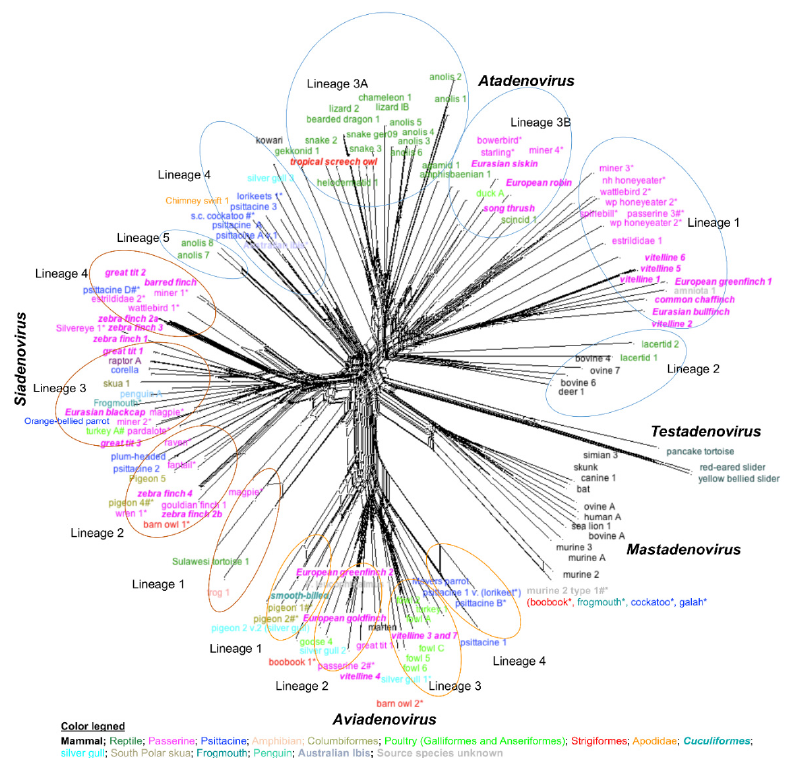
Figure 3. Bootstrap network analysis using partial DNA polymerase gene amino acid sequences. Bootstrap values that exceeded 80% are highlighted with line weight as generated by SplitsTree software. Groups of host species were coloured as shown in the colour legend. Murine adenovirus 2 variant 1 was found in the four species of birds in parenthesis; however, it is suspected to be of murine origin. Virus sequences identified in the study conducted by Vaz et al. (2020) [10] were shown with an asterisk (*), whereas adenoviruses identified with a hashtag (#) were found in more than one species of bird, either in the study by Vaz et al. (2020) [10], and/or one or more studies by others [2,9,16–18,24–42]. Recent adenovirus sequences reported from Europe [44] and South America [43] were also included and highlighted with a bold and italic font. Lineages are designated according to Vaz et al. (2020)